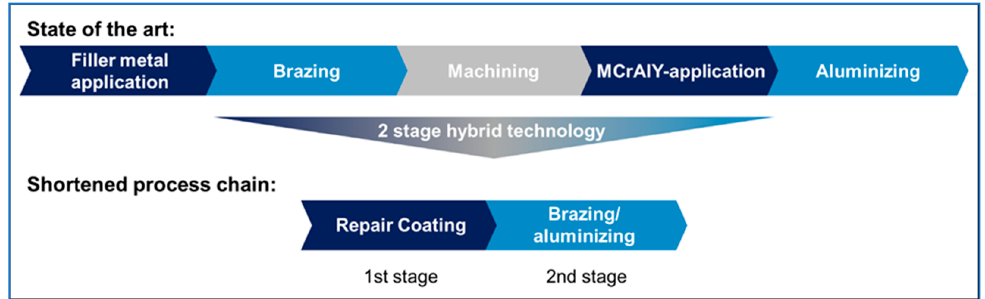
Figure 2. Principle of the coating and joining hybrid technology, recompiled from [15].